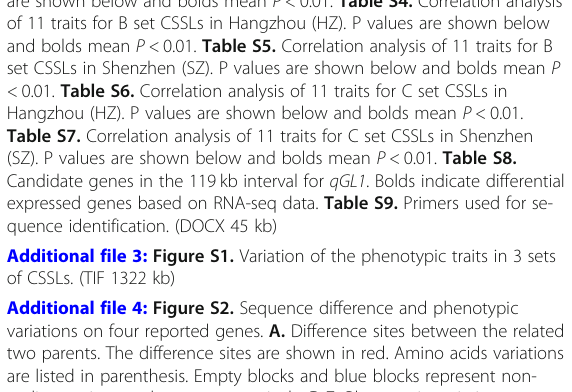
Additional file 5: Figure S3. Double-crossovers in CSSLs. Different colors represent different genotypes: red, 9311; blue, PA64s; green, Nipponbare. Double-crossovers were shown in black panes. (TIF 1447 kb) Additional file 6: Figure S4. Quantitative real-time RT-PCR analysis and Sequence variations of predicted genes. A-C. RNA relative expression level of 9311, Nip and CSSL-B54 in young panicle for LOC_Os01g53140 , LOC_Os01g53140 and LOC_Os01g53250 , respectively. D-F. Sequence variations between Nip and 9311 for LOC_Os01g53140 , LOC_Os01g53140 and LOC_Os01g53250 , respectively. Values represent means ± SD of three independent assays. ** indicate the least significant difference at 0.01 probability level compared with 9311. NPB represents Nipponbare. SNPs on the exons are shown in bold and Amino acids variations are listed in parenthesis. (TIF 3099